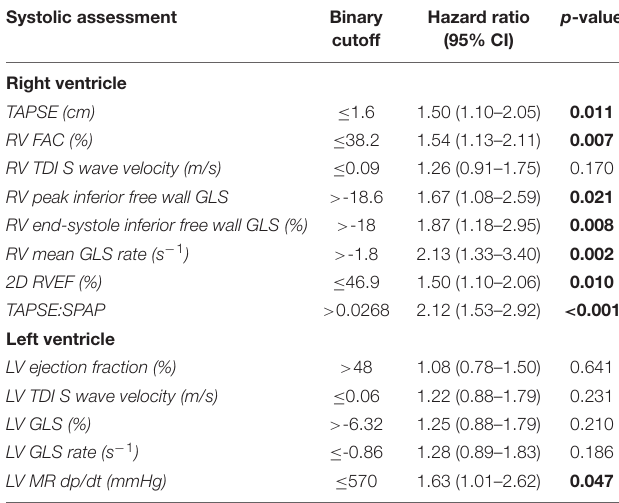
TABLE 1 | Assessments of right ventricular (RV) and left ventricular (LV) systolic dysfunction. Systolic assessment